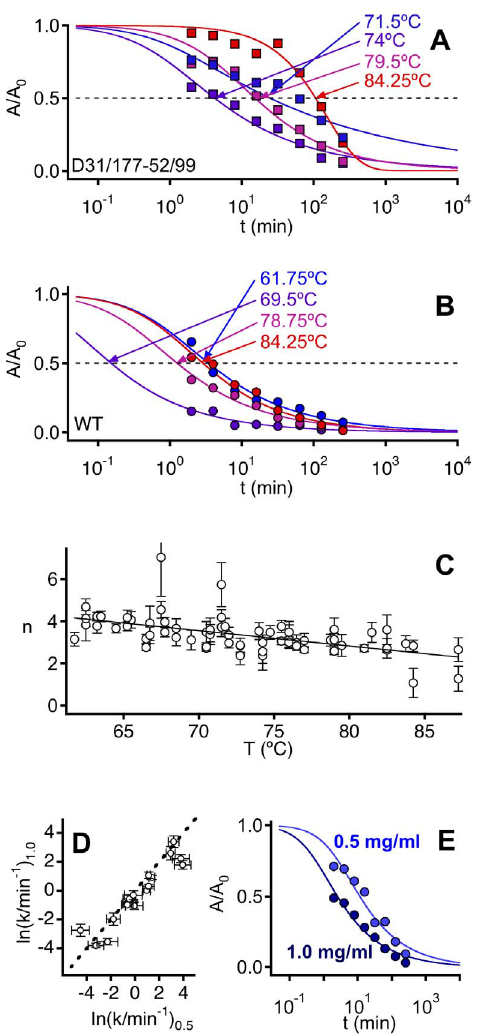
Figure 6. Thermal inactivation kinetics data for wild-type phytase and variants. (A) and (B) Illustrative plots of activity versus time for experiments performed at several temperatures with (A) a variant with two engineered bridges and (B) wild-type. Total protein concentration is 0.5 mg/mL. The continuous lines represent the best fits of equation 1 to the experimental data. The fastest kinetics are observed at an intermediate temperature (74 u C in A and 69.5 u C in (B). (C) Values of the reaction order derived from the fitting of equation 1 to inactivation profiles for wild-type phytase and all the variants. (D) Agreement between the rate constants obtained with total protein concentration of 0.5 and 1 mg/mL. (E) Representative example of the protein concentration effect on the rate of irreversible denaturation (variant D1, 76 u C).